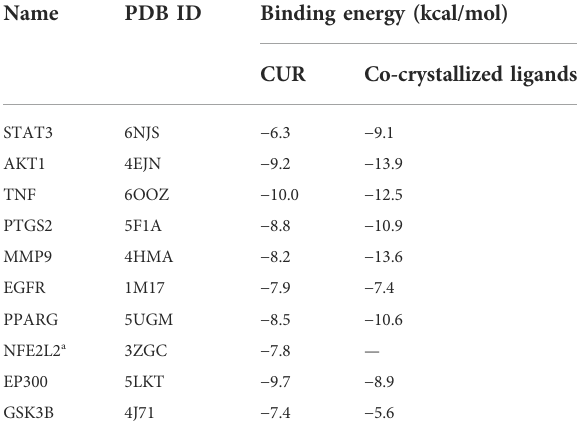
TABLE 1 The scores of the top 10 targets of CUR against TNBC calculated by the MCC method. Rank